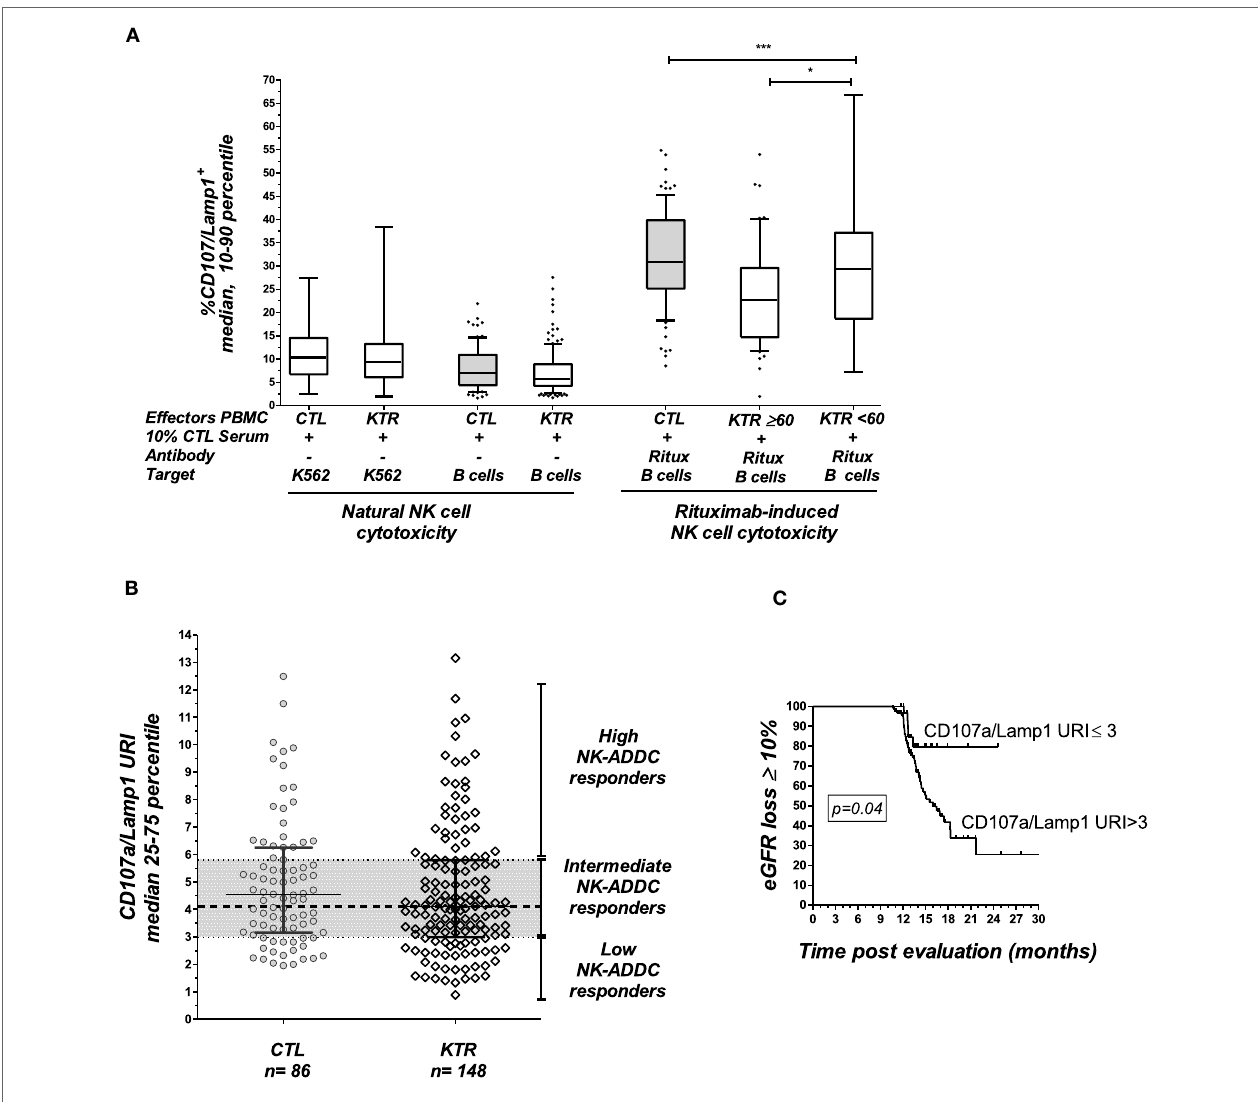
FigUre 2 | analysis of nK cell activation in late kidney transplant recipients . (a) The natural cytotoxicity of NK cells toward HLA-negative K562 cells or CD20 + B-lymphocyte target cells was analyzed by multicolor flow cytometry. The expression of CD107a/Lamp1 on the surface of CD3 − CD56 + NK cells gated within the PBMCs was analyzed. NK cell ADCC toward the same B cell targets was evaluated in the presence of rituximab (Ritux). NK cell activation was evaluated in 148 KTRs and 86 healthy controls (CTL). The KTR patients were grouped according to graft function as follows: normal graft function (eGFR ≥ 60 mL/min/1.73 m 2 , n = 56) and moderate-to-severe graft dysfunction (eGFR < 60 mL/min/1.73 m 2 , n = 92). One-way ANOVA was performed to test the significance of NK-ADCC using PBMC effector cells obtained from CTLs and the KTR subgroups (Kruskal–Wallis, p = 0.0002). Asterisks indicate the p values as follows: * p ≤ 0.05, ** p ≤ 0.01, and *** p ≤ 0.001. The box plots show the median values, and the whiskers represent the 5–95 percentiles. (B) Specific analysis of rituximab-induced NK cell activation. To analyze the specific contribution of antibodies, NK cell activation toward rituximab-coated B cells was normalized in reference to the baseline cytotoxicity of the NK cells toward B cells evaluated in the absence of rituximab by calculating the CD107a/Lamp1 upregulation index (CD107a/Lamp1URI). The CD107a/Lamp1URI values observed in the KTR cohort allowed classification of the KTRs as low ADCC responders if their CD107a/Lamp1URI was below 3 (25th percentile) or as intermediate or high responders if their CD107a/Lamp1URI value was greater than 3. (c) Kaplan–Meir curves for an eGFR loss of at least 10% or graft loss ( n = 51) observed during the follow-up period (months post-inclusion in the study) in KTRs with low NK cell activation (CD107a/Lamp1URI ≤ 3) and intermediate or high NK cell activation (CD107a/Lamp1URI >